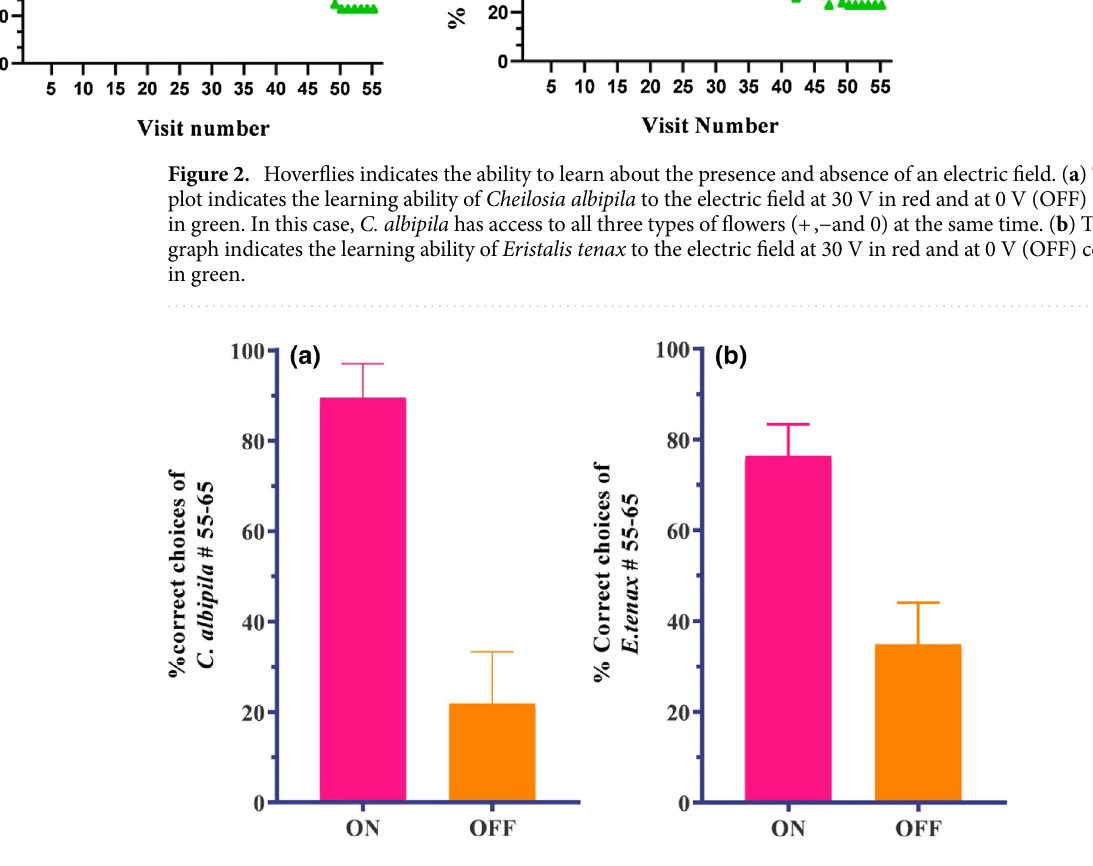
Figure 3. ( a ) Percent of correct choices of Cheilosia albipila to last ten visits to rewarding (ON) and non- rewarding (OFF) e-flowers while the error bars show the SEM (Standard error means) ( b ) Percent of correct choices of Eristalis tenax to last ten visits to rewarding (ON) and non-rewarding (OFF) e-flowers while the error bars show the